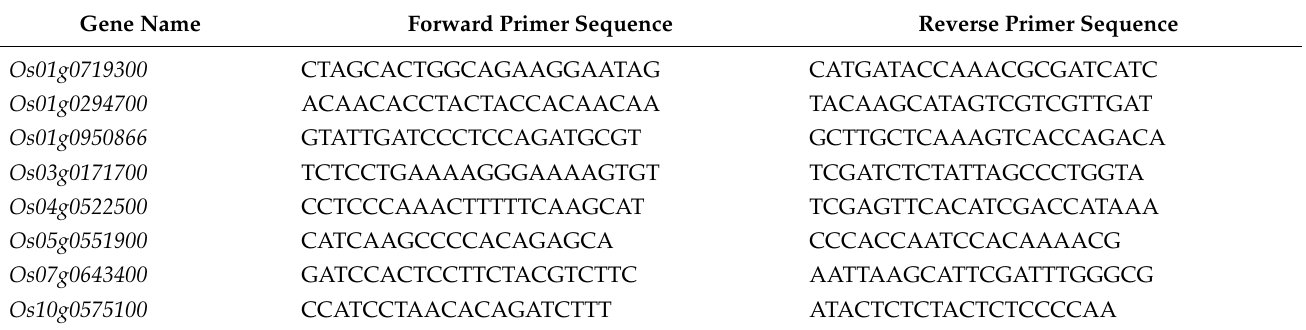
Table 1. qRT-PCR primer